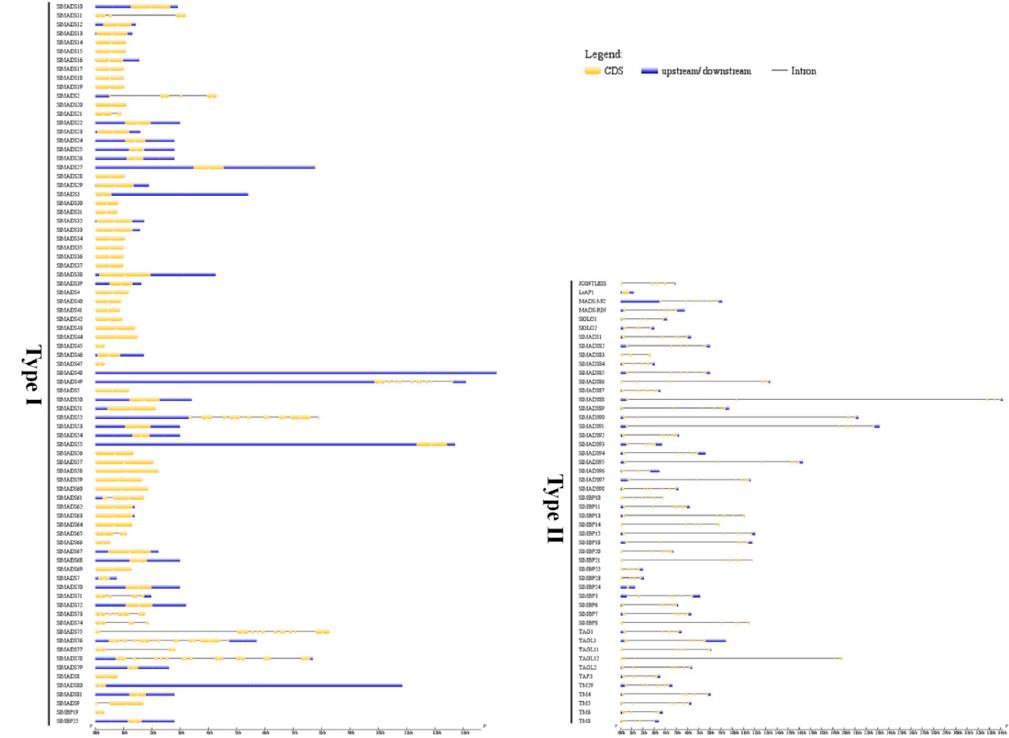
Figure 1. Gene structure analysis of MADS-box genes in tomato. The Gene Structure Display Server (GSDS) database was used to perform the exon–intron structure analyses. Lengths of exons and introns of each MADS-box gene were displayed proportionally. The blue boxes represent upstream/downstream, the yellow boxes represent exons, and the black lines represent introns.